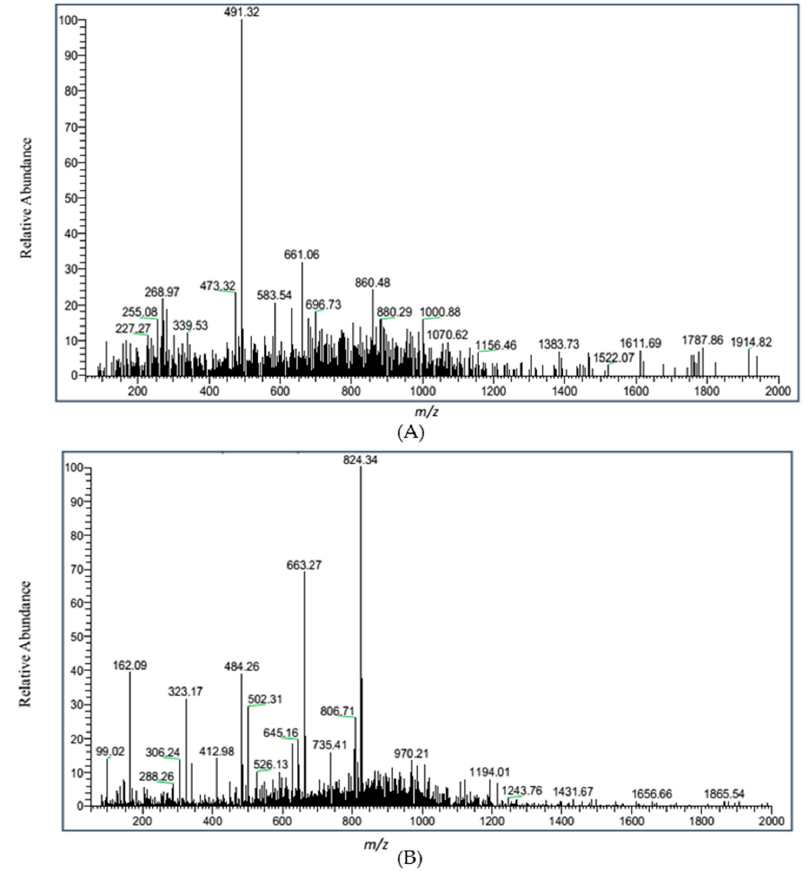
Figure 5. The negative ion electrospray ionization mass spectrometry (ESI-MS) spectra of: OCHA ( A ); and OCHB ( B ). The undelined m / z numbers might be decuded as some fragment ion peaks.